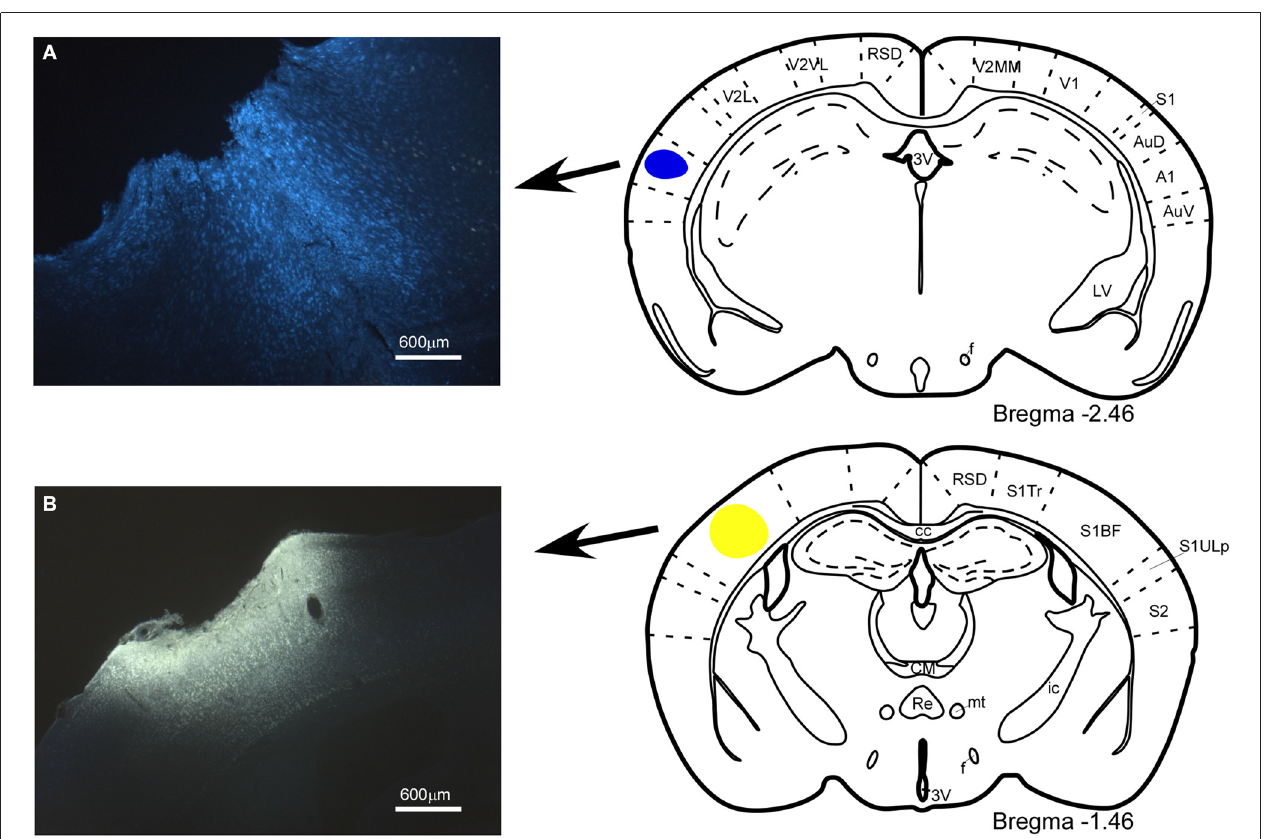
FIGURE 1 | Location of the injection and deposit of fluorescent retrograde tracers . Microphotographs of coronal brain sections and schematic drawings showing the injection sites of the retrograde tracers. (A) Fast Blue (FB), deposit in the A1 cortex; (B) Fluoro-Gold (FlGo), injection in the S1 cortex. In this and in the following figures, abbreviations are: 3V, 3rd ventricle; A1, primary auditory cortex; AuD, secondary auditory cortex, dorsal area; AuV, secondary auditory cortex, ventral area; cc, corpus callosum; CM, central medial thalamic nucleus; f, fornix; ic, internal capsule; LV, lateral ventricle; mt, mamillothalamic tract; Re,